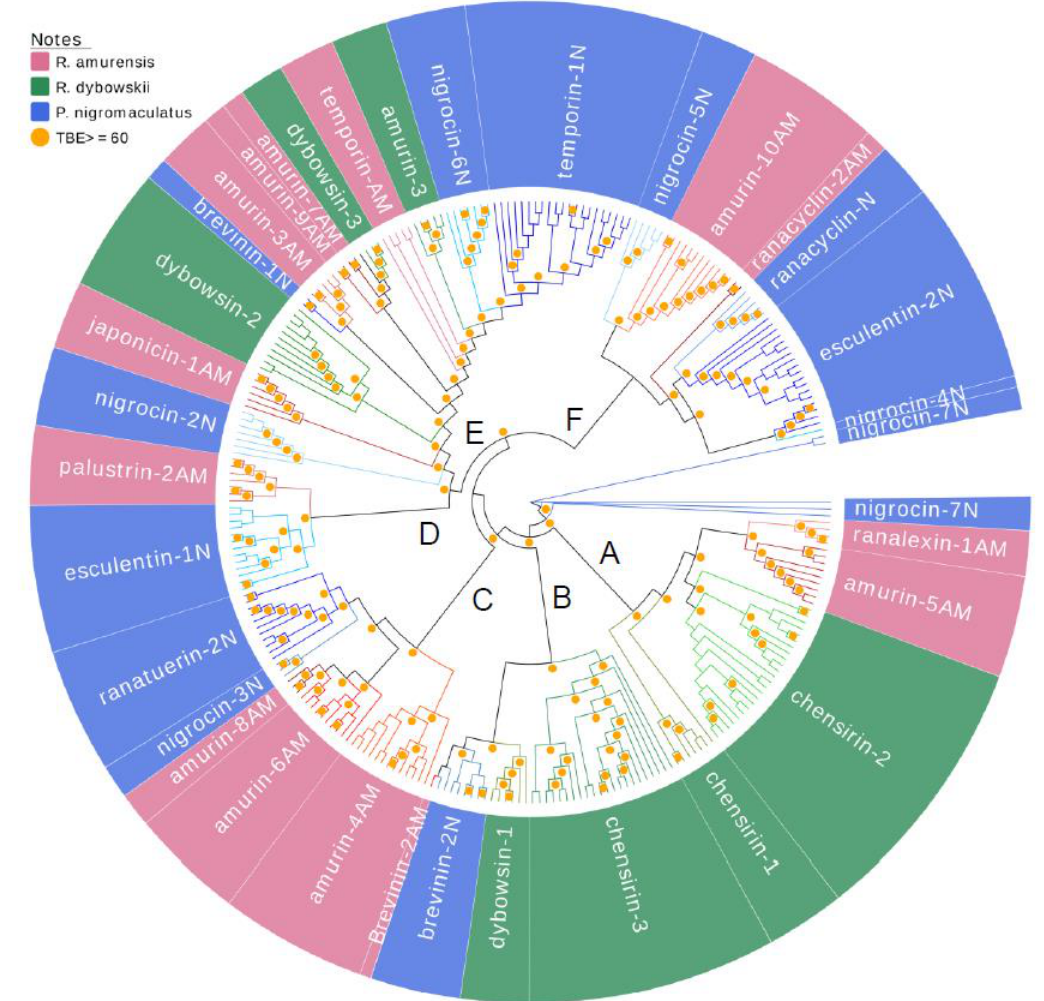
Figure 5. A phylogenetic tree of all antimicrobial peptide (AMP) genes identified from three anuran species, namely R. amurensis (pink), R. dybowskii (green) and P. nigromaculatus (blue). Orange dots in the figure are confidence values with transfer bootstrap expectation (TBE) 1000 replicates; only values ≥60 are shown.